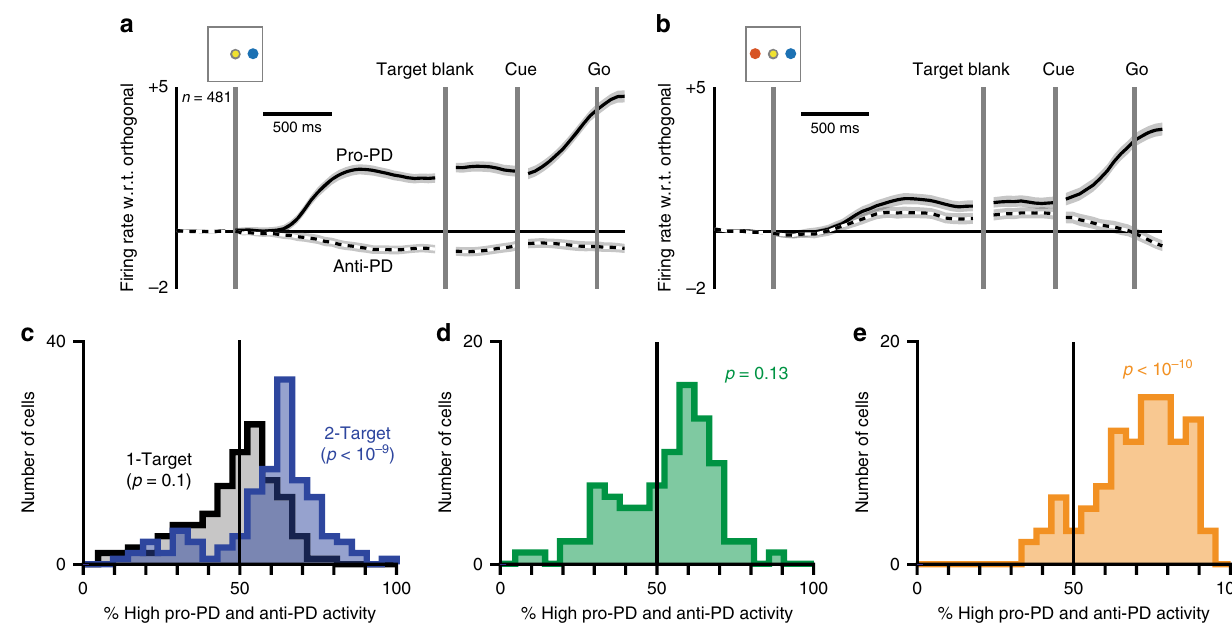
Fig. 2 Apparent dual representation from trial averaging. a Average activity traces of neurons with preferred directions aligned (solid) and anti-aligned (dashed) with the reach direction across all 1-Target trials. Activity of neurons with preferred directions orthogonal to cue direction has been subtracted. Shading represents bootstrapped 95% con fi dence. b Average traces (as in a ) for all 2-Target trials. c Histograms showing the percentage of activity during pro-PD and anti-PD trials that exceeded the median activity observed on orthogonal-PD trials. Rightward skew on 2-Target trials (blue) suggests simultaneous representation. p -Values correspond to the null hypothesis that the distribution mean is 50% ( t -test). d Analysis as in c for a simulation of an unbiased guessing approach using 1-Target data. e Analysis as in c for a simulation of a biased guessing approach using 1-Target data